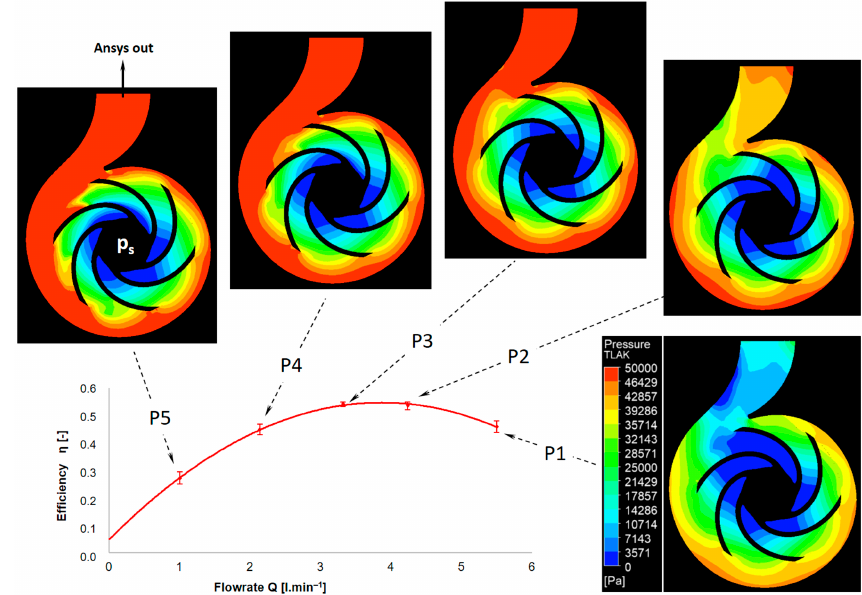
Figure 9. Pressure fields in the impeller and spiral casing (Ansys, setting 1).